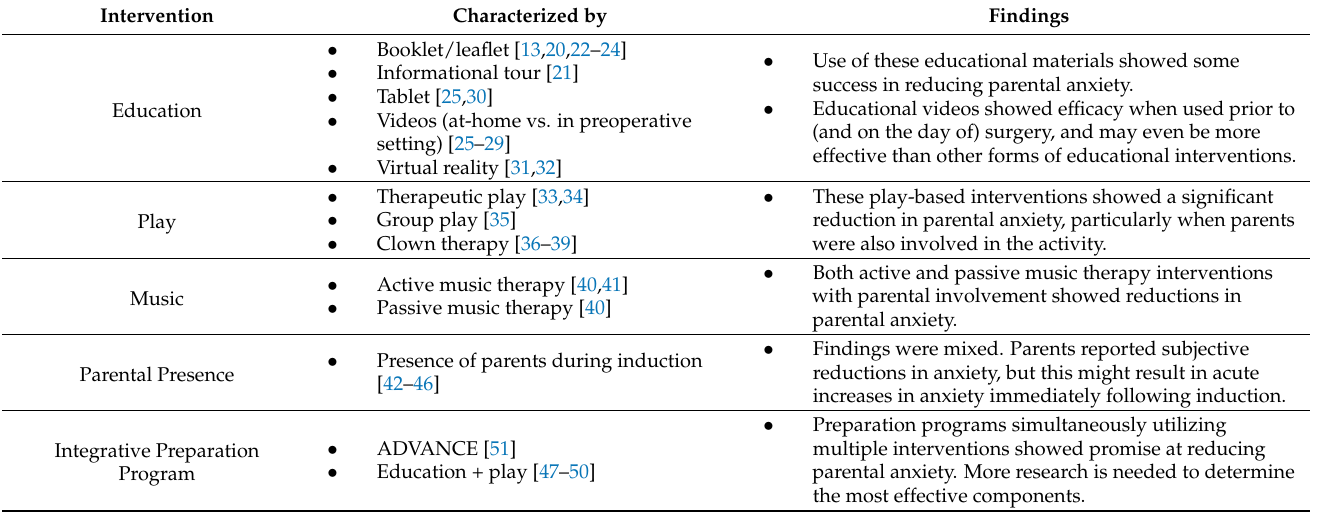
Table 1. Summary of findings on interventions aimed at reducing preoperative parental anxiety. Intervention Characterized